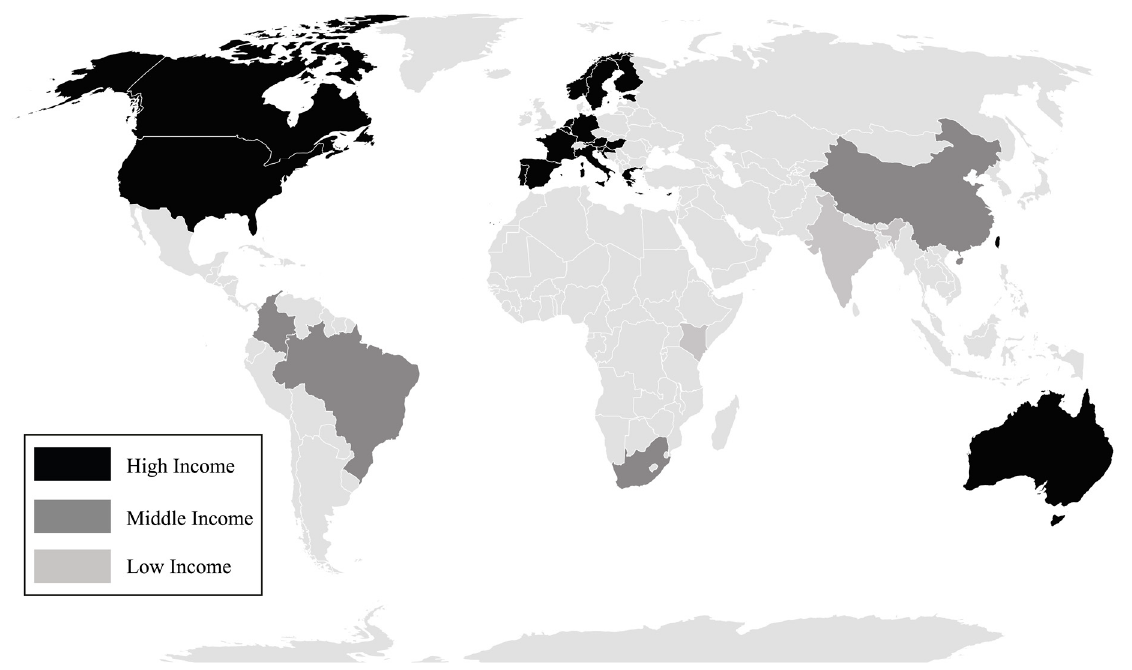
Figure 2. Countries included in the scoping review according to income level. Source: by the